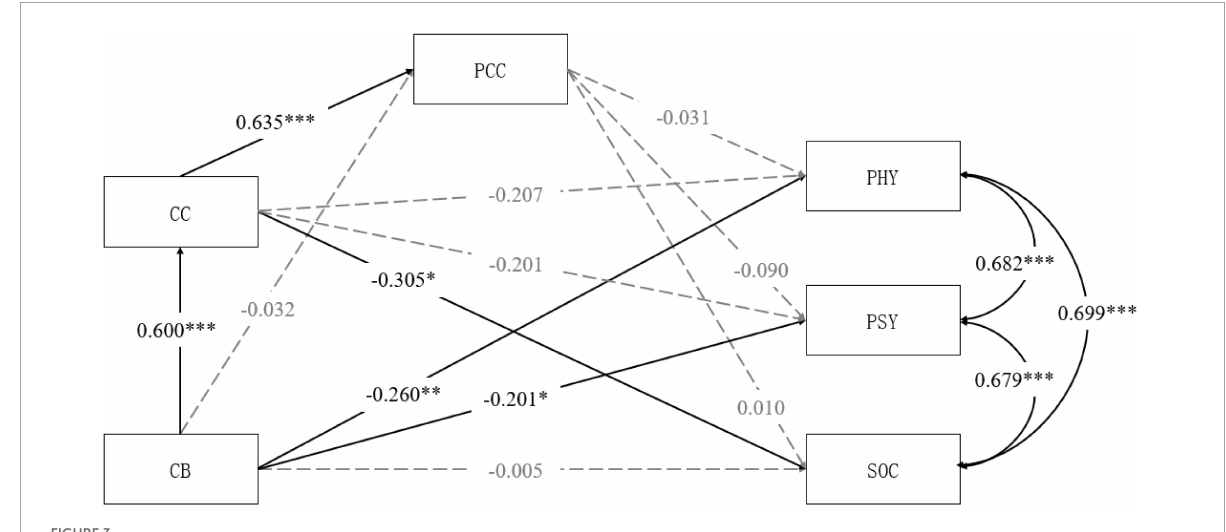
FIGURE3 The mediating model of CC and PCC between CB and QoL (PHY, PSY, and SOC). CB, care burden; CC, caregivers’ criticism; PCC, patients’ perceived criticism; PHY, physical domain of patients’ QoL; PSY, psychological domain of patients’ QoL; SOC, social relationships domain of patients’ QoL. ∗ p < 0.05, ∗∗ p < 0.01, ∗∗∗ p <